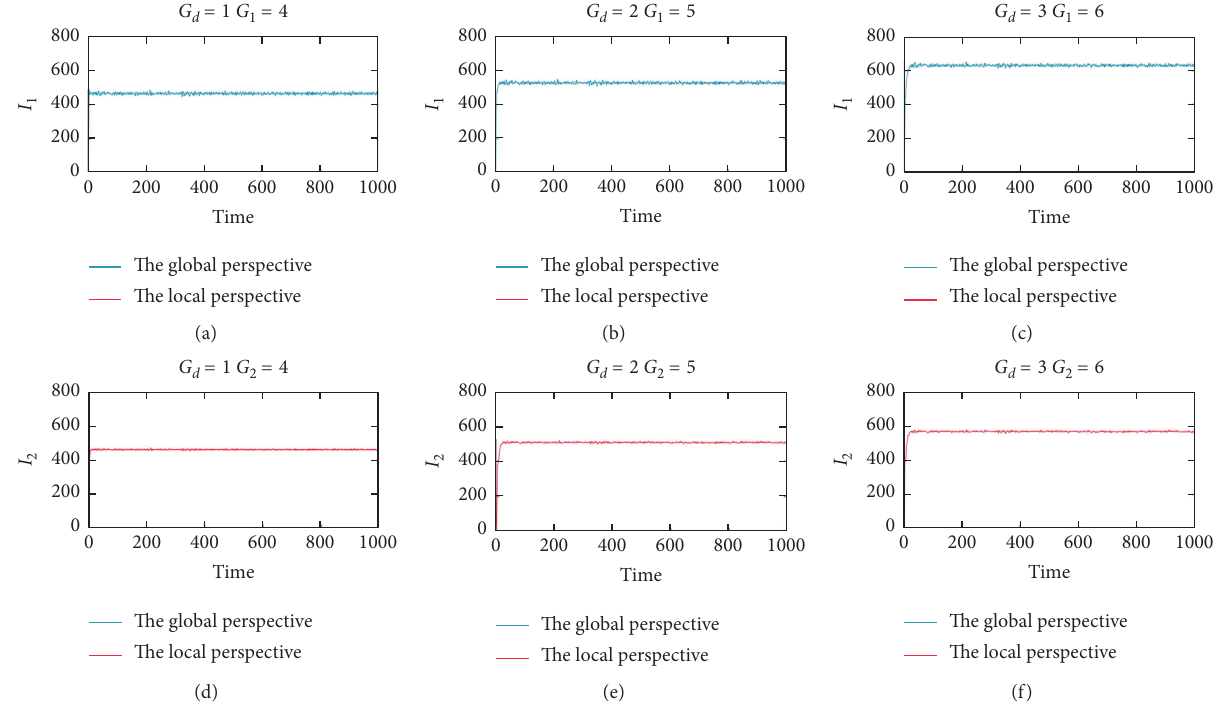
Figure 24: The initial inventory changes of the system from the perspective of decision under the scenario of random demand obeying normal distribution from different